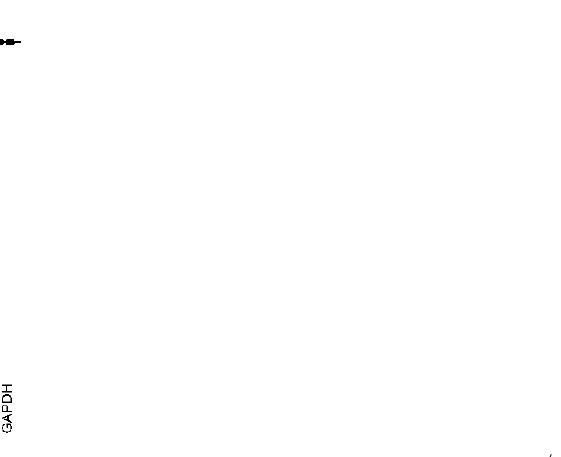
Figure 5. Cytokine profiling in DMPA treated vaginal tissues from Nu/J heterozygous mice (Foxn1 nu/+ ). Transcripts of a panel of anti-viral cytokines including IL36 γ , IL-17A, IL-6, GATA-3, TNFa, Arrb2 etc. were analyzed and normalized to GADPH. When compared with PMSG treated animals, significant reduction of these cytokines was found in DMPA treated vaginal tissues when compared with that in the PMSG treated group ( p < 0.05, Wilcoxon rank sum tests).